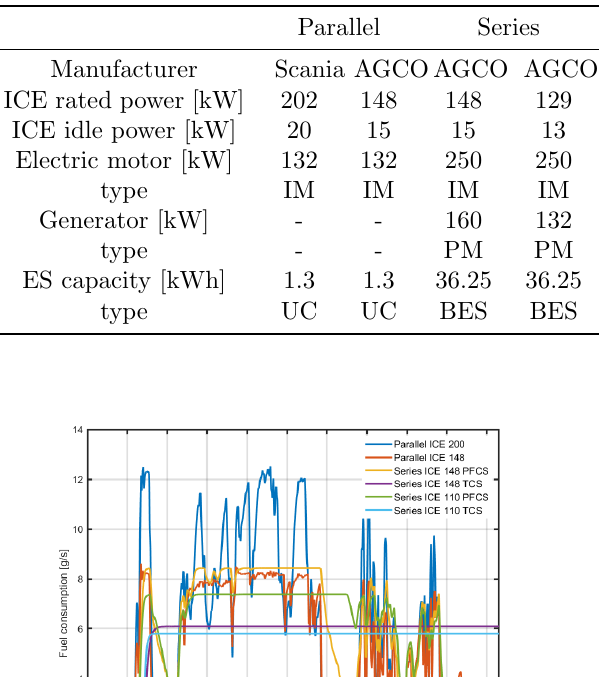
Table 2: Simulation results of the backhoe loader with different topologies and control strategies (CS): EACS - Electric Assist CS, TCS -